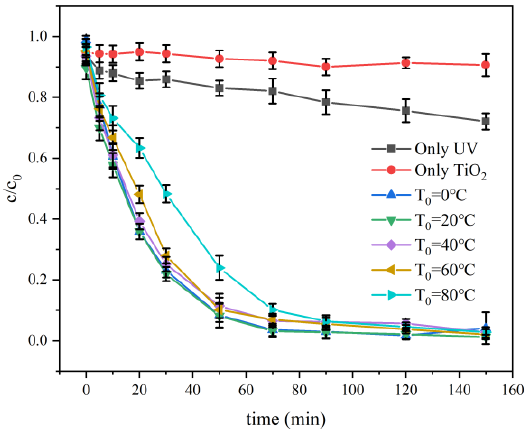
Figure 5. Variation of AR 26 concentration at cooling water temperatures of 0, 20, 40, 60, and 80 °C. Variation of the Temperature of Wastewater at Bottom of Reactor